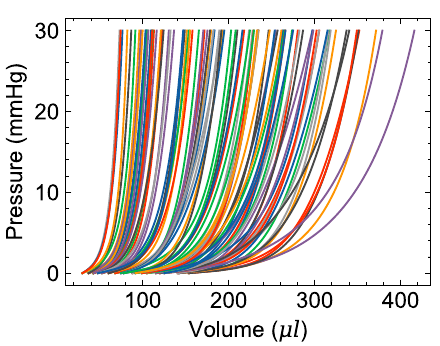
Figure 7. Representative EDPVRs (100 out of 2500) in ML training dataset resulting from a wide variety of heart geometries, fiber orientations, and myocardial stiffness.